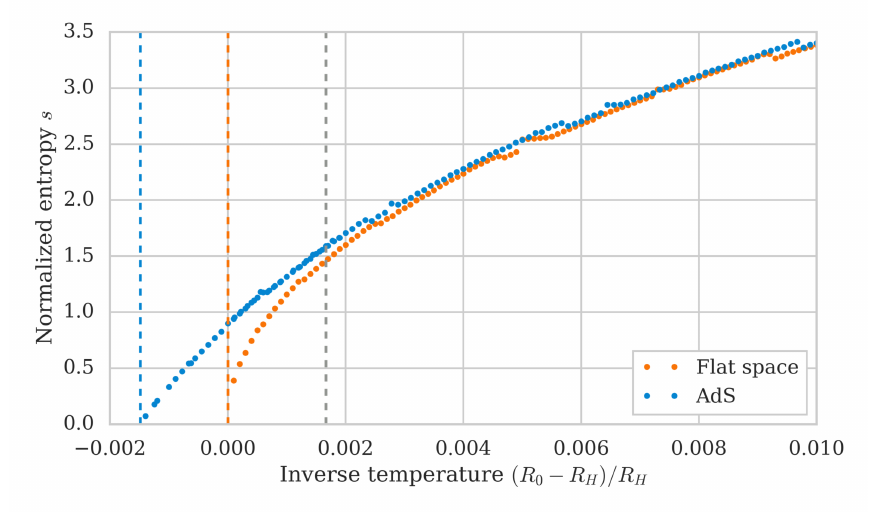
Figure 4 . Numerical estimation of the string star normalized entropy s as a function of ( R 0 − R H ) /R H . The numerical calculation was done for the d = 3 heterotic string. In blue is the AdS solution with l = 600 , and in orange the flat space solution. The gray vertical line is the ads /l s temperature scale around which the AdS solutions significantly deviate from flat space. The orange vertical line is the flat space Hagedorn temperature R , and the blue vertical line is the AdS H Hagedorn temperature R . c